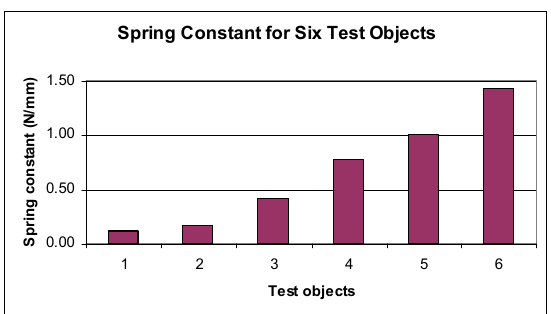
Fig. 5. Spring constant of the six test objects.